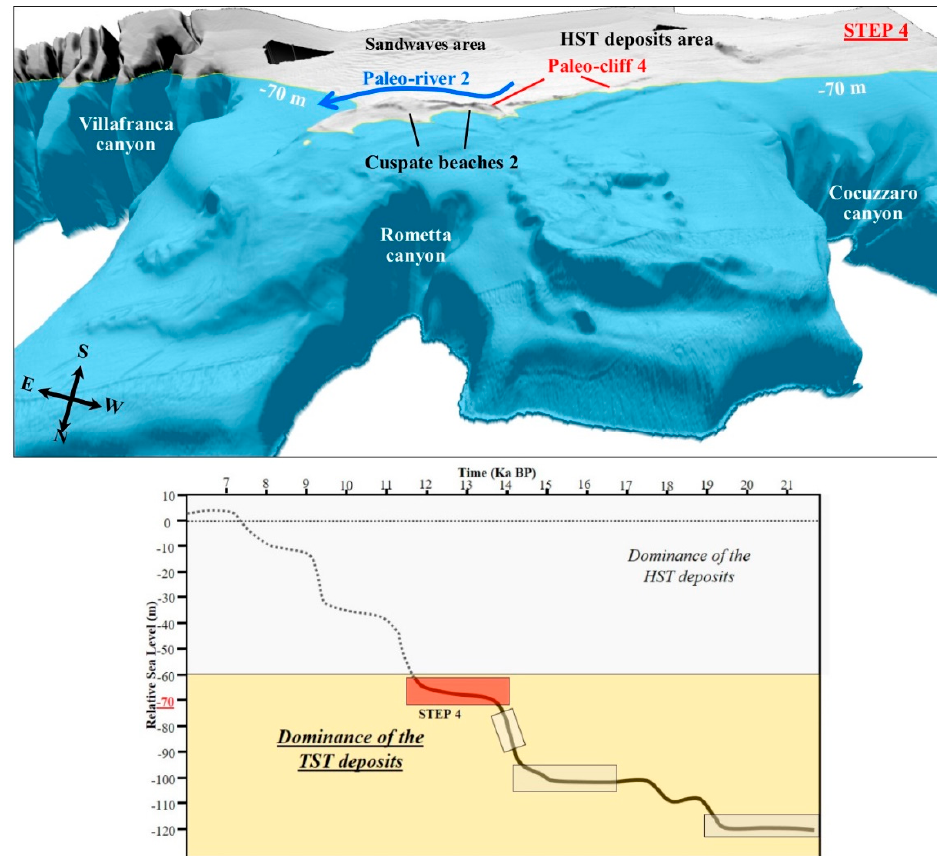
Figure 10. On the basis of a 3D bathymetric map, the reconstruction of the geomorphological evolution of past coastal systems of the area between the Cocuzzaro and Rometta canyons, simulating a sea level of − 70 m.